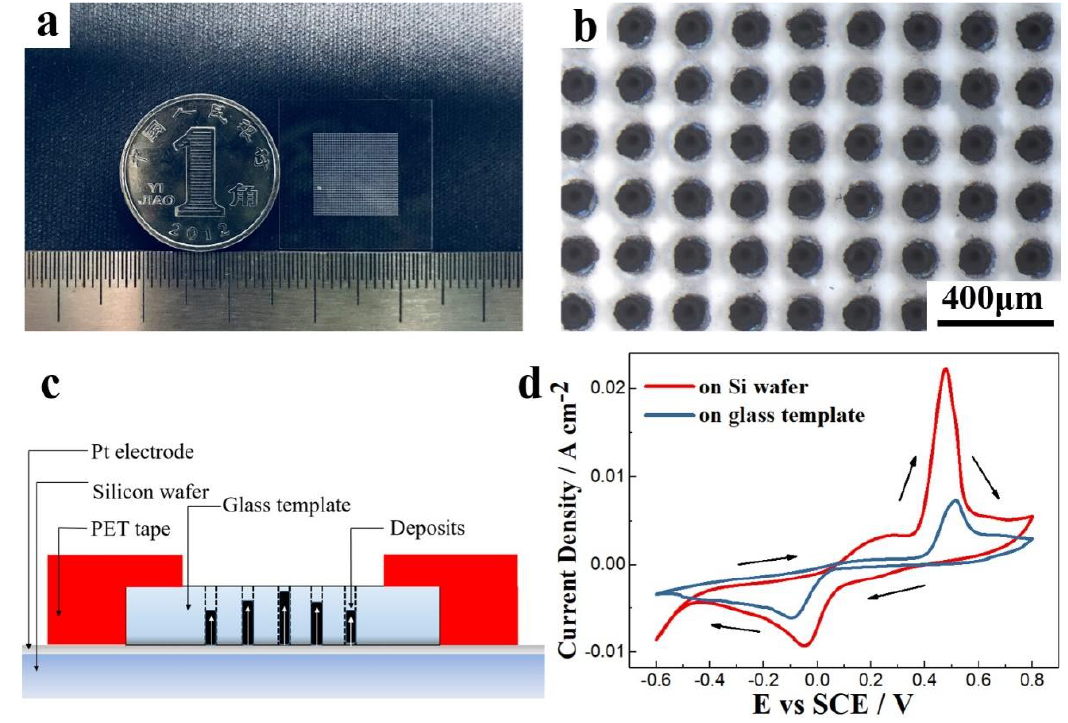
Figure 9. ( a , b ) Physical and optical micrographs of a microporous glass template. ( c ) The schematic of the electrode structure. ( d ) CV curves for 7.5 mM Bi and 10 mM Te when scanning on the silicon wafer and the microporous glass template.